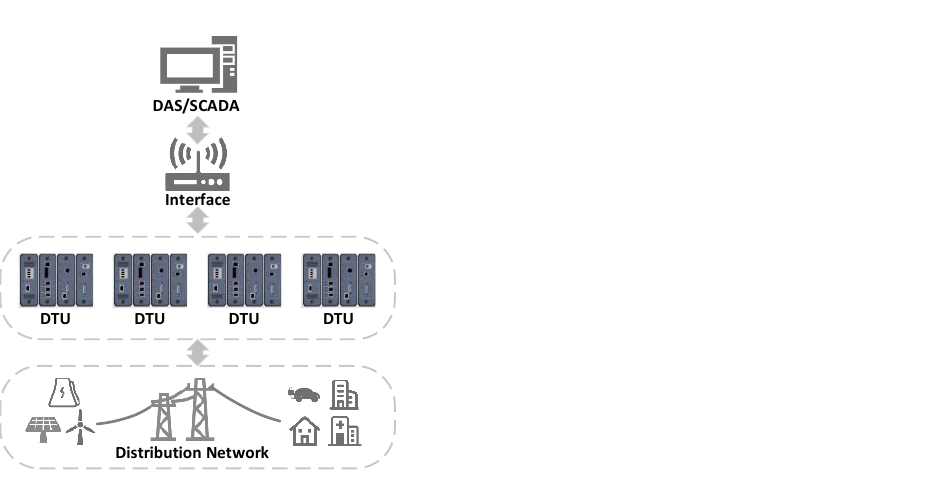
Figure 1. DTU in the power system.